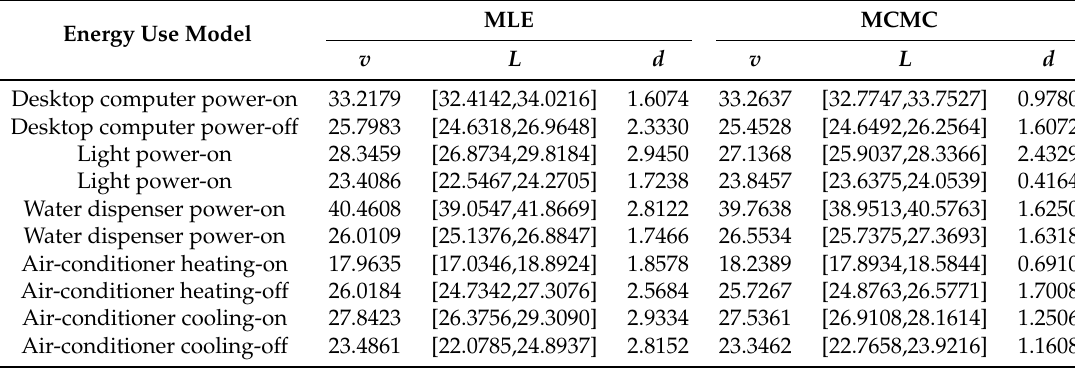
Table 2. Comparison results of MLE and MCMC.